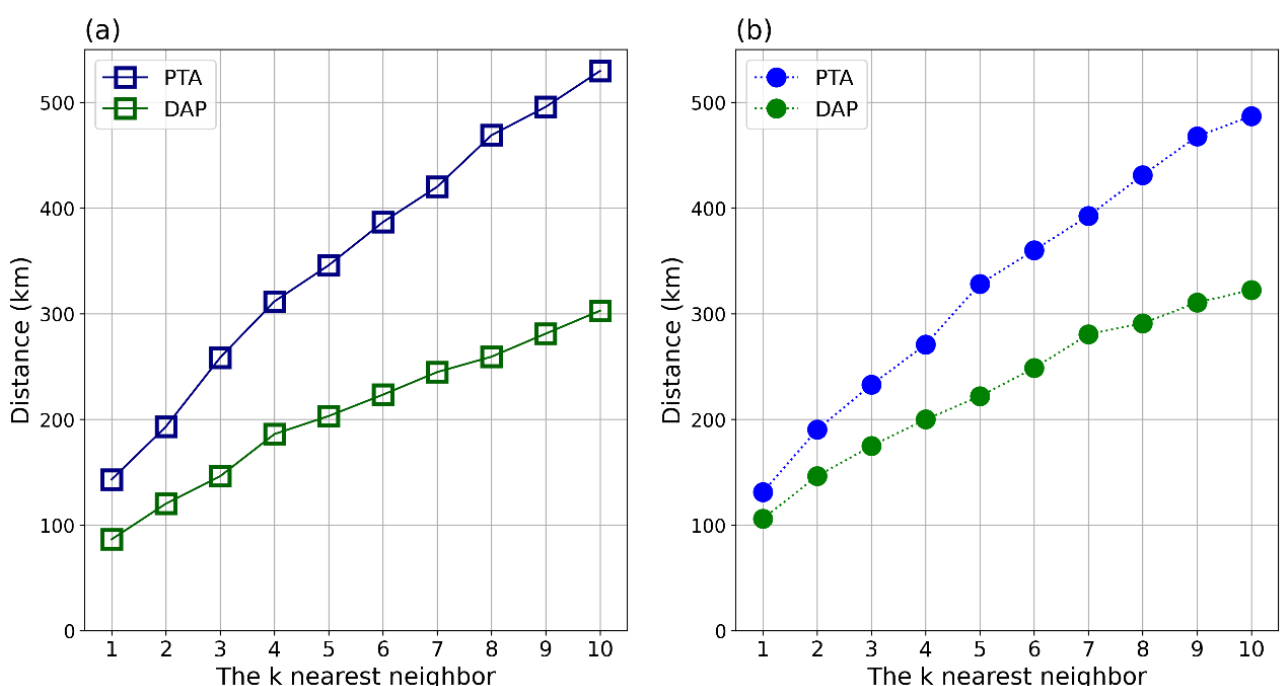
Figure 5. Spatial proximity of cities with declining railway network properties to cities with rising properties, where k varies from one to ten. ( a ) The square lines are the D-series high-speed trains, and ( b ) the circle lines are the G-series high-speed trains. Blue is PTA, and green is DAP.